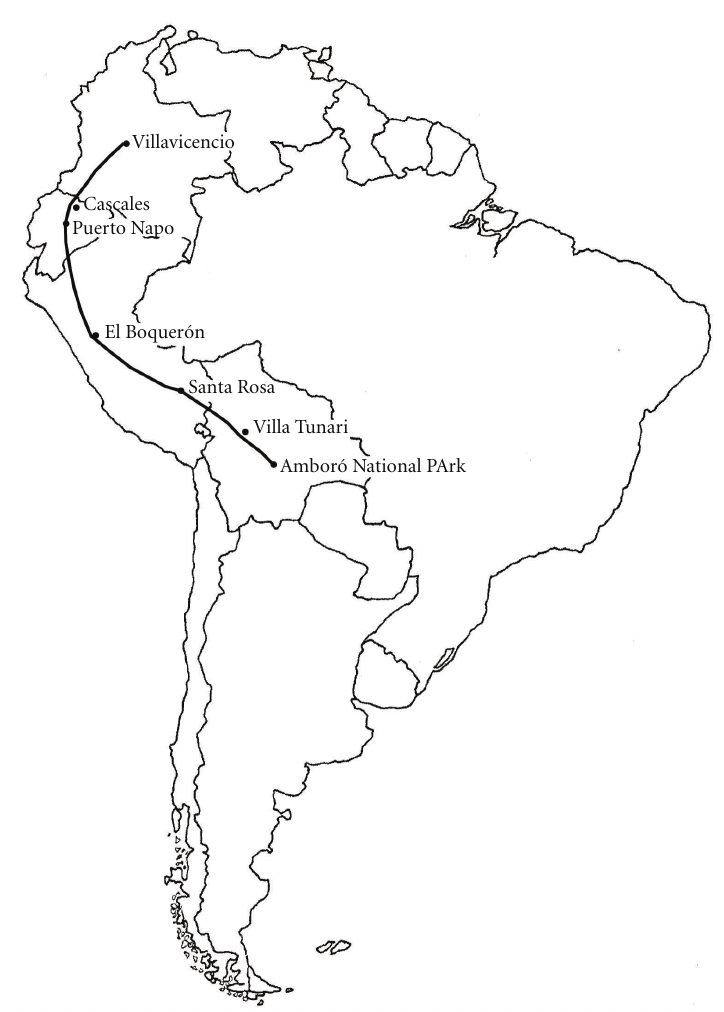
Figure 2: Western boundary of Amazonia suggested in this